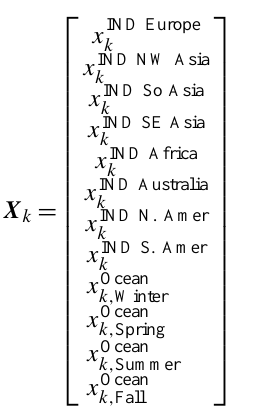
Fig. 3. Partitioning of the global industrial CCl source into the eight regions is shown 4 along with the T42 MATCH grids. The regional source magnitudes are estimated in the Kalman filter as 12-month average values. The spatial distributions (but not total emissions) within each source region and for the ocean sink remain at their a priori